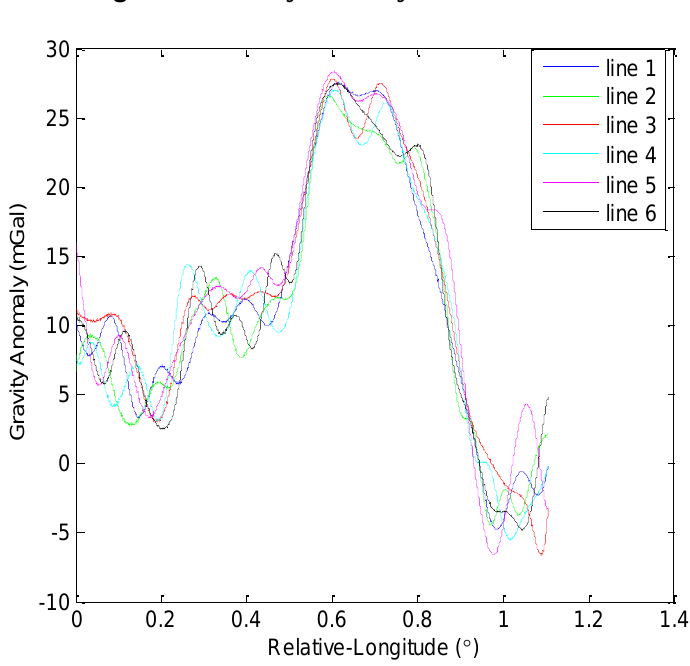
Figure 7. Gravity anomaly curves of